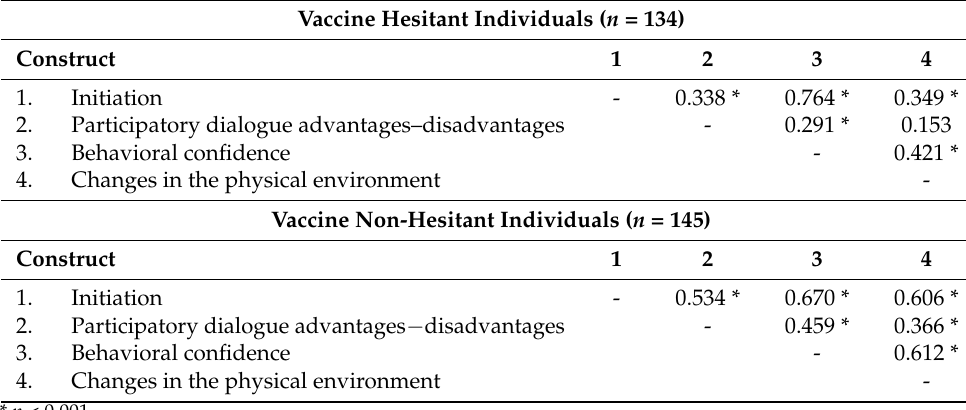
Table 3. Zero-order correlation matrix of study